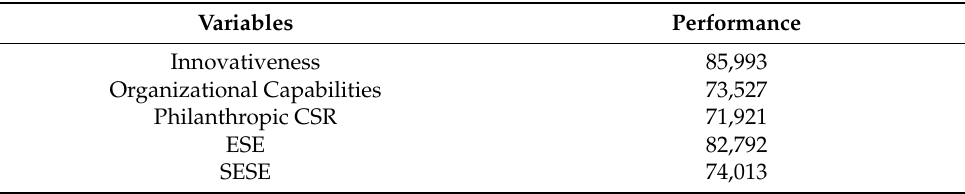
Table 4. Performance: IPMA for